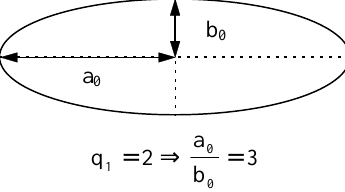
Fig. 11. Identified elliptic microvoid